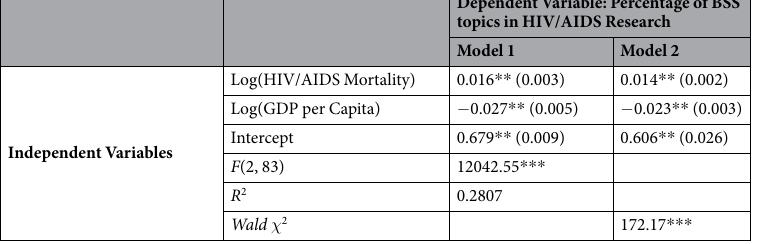
Table 1. Panel data regression results for percentage of BSS topics. * p < 0.05 ** p < 0.001 *** p < 0.0001. Standard errors are presented in